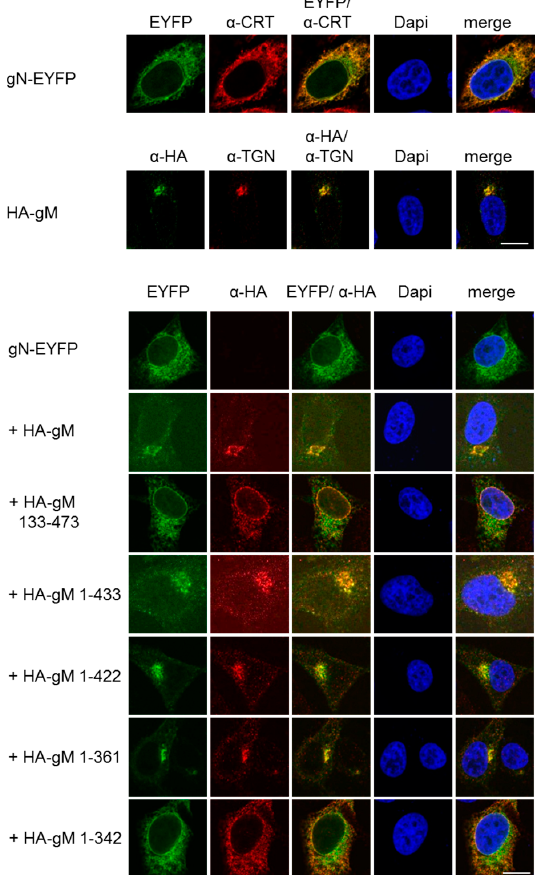
Figure 2. HSV-1 gN is an ER resident that requires the hydrophobic core of gM for transport to the TGN. To follow their subcellular distribution, gN–EYFP or HA–gM were transiently expressed either alone or combining gN–EYFP with either full-length (HA–gM) or N- and C-terminal truncation mutants of gM (HA–gM 133–473, HA–gM 1–433, HA–gM 1–422, HA–gM 1–361, HA–gM 1–342) in HeLa cells for 20 h. Anti-HA antibodies were used to detect the localization of gM and gM truncations, followed by secondary reagents. gN–EYFP was visualized directly. Antibodies recognizing the marker proteins Calreticulin (CRT) and TGN46 were used to visualize the ER and the TGN, respectively. Nuclei were visualized by DAPI staining. The scale bars correspond to 10 µ